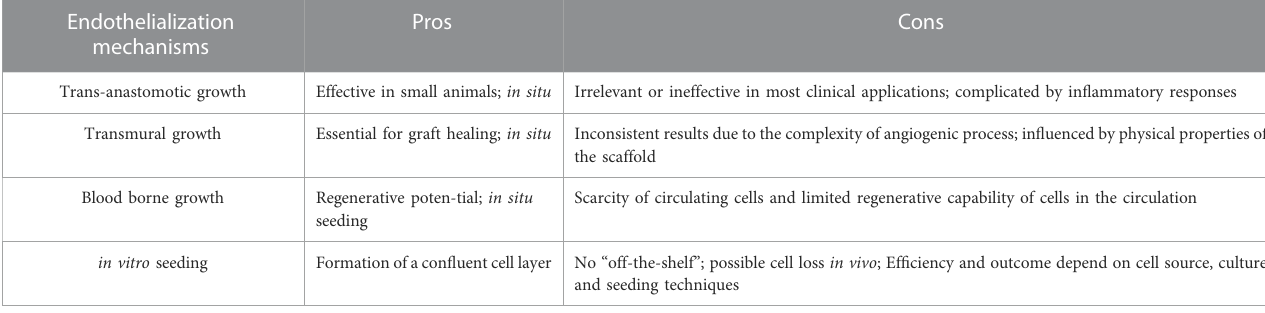
TABLE 1 Summary of comparisons among four endothelialization mechanisms.